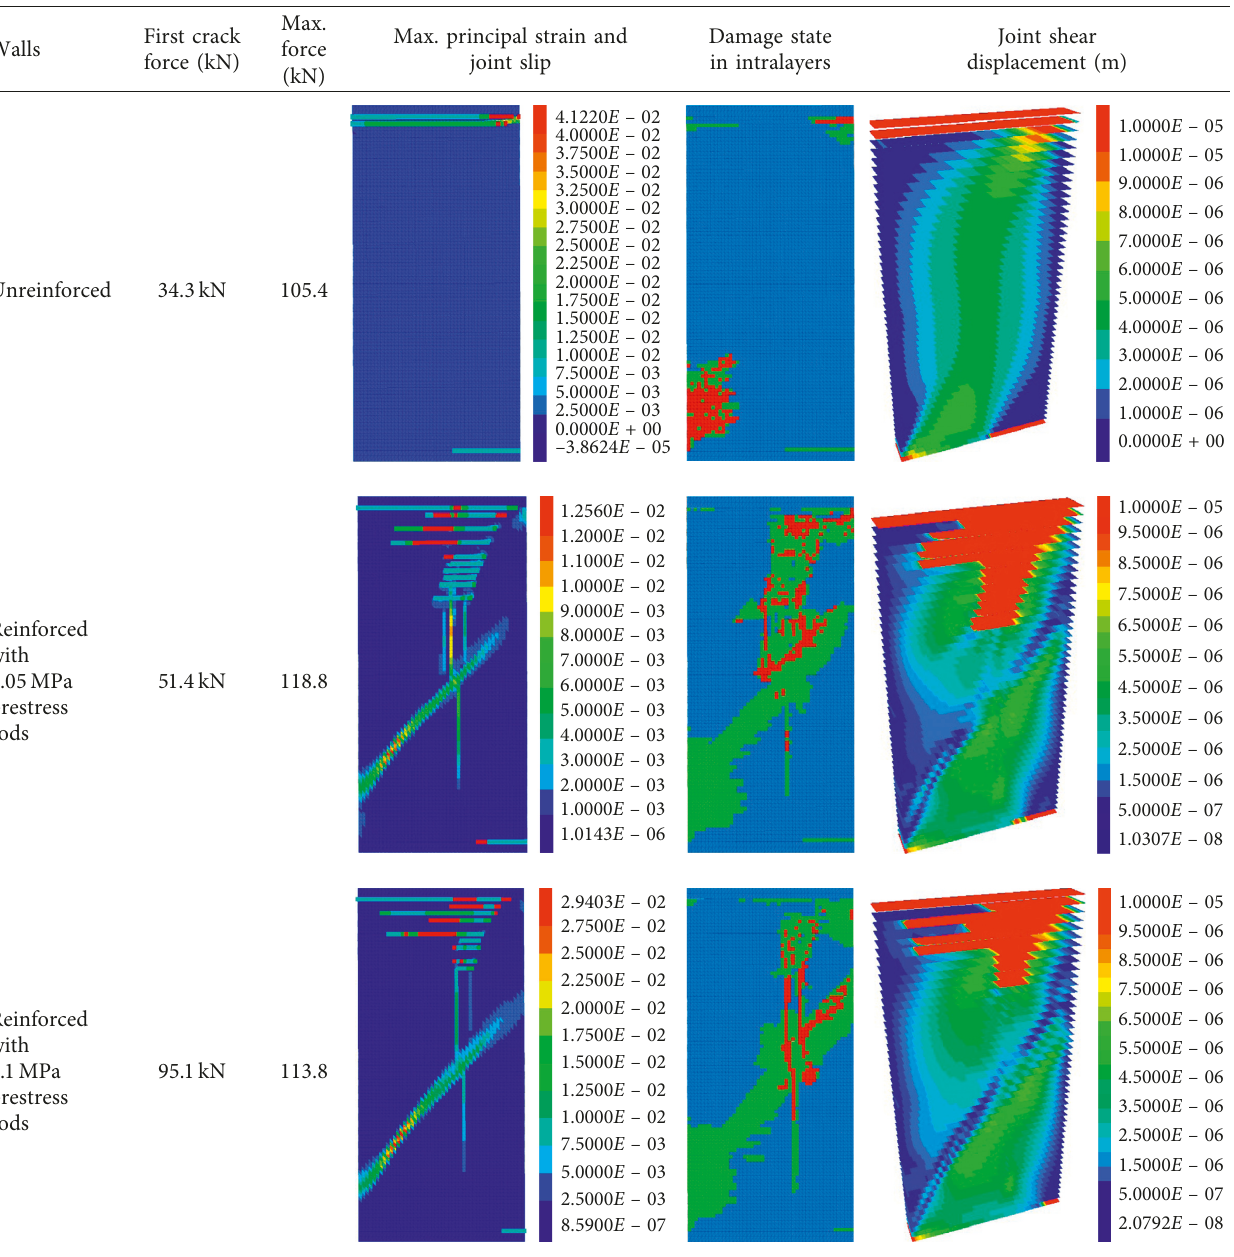
Table 3: Damages and the corresponding forces obtained (the pushing direction is the same as in Figure